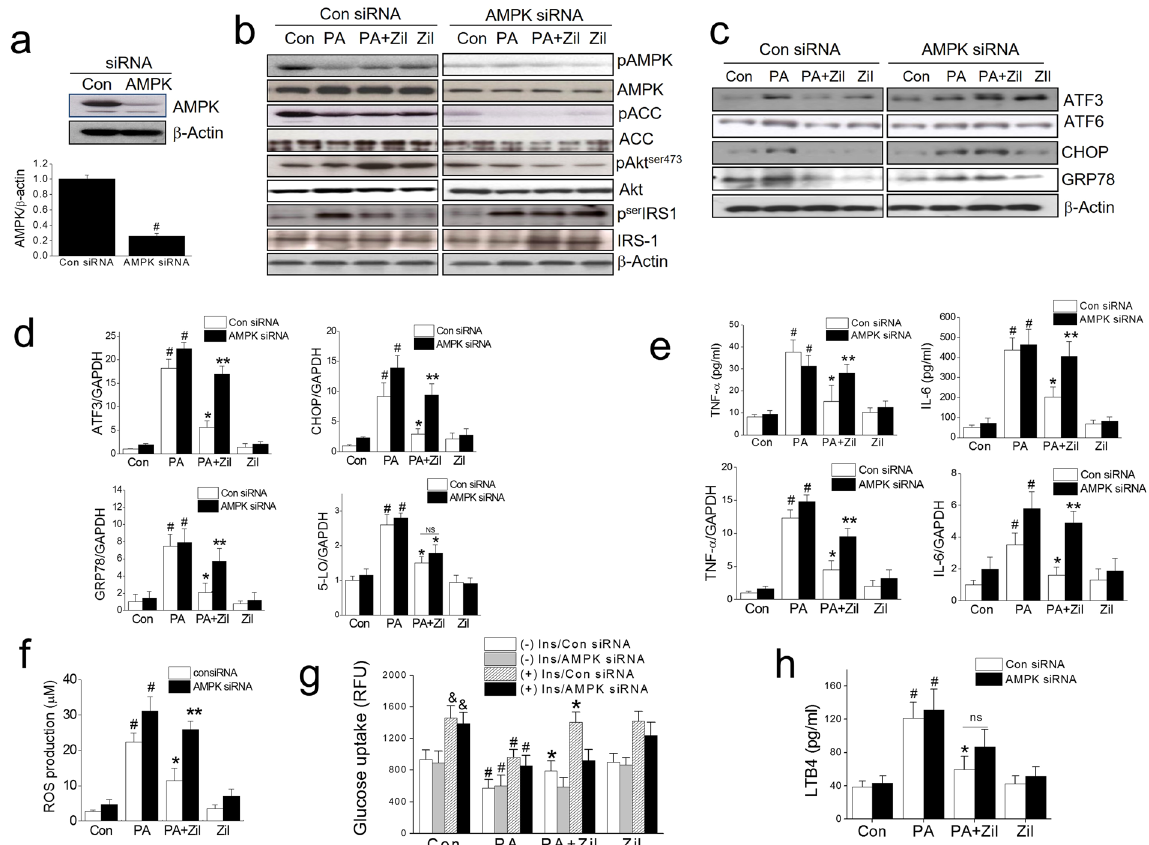
Figure 7. The effect of AMPK knockdown on the zileuton action. C2C12 myotubes were transfected with negative control siRNA or AMPK siRNA (20 nM), treated with 50 μ M zileuton for 1 h, and then with PA (750 μ M) for 12 h (qPCR) or 24 h (western blot, ELISA, ROS, and glucose uptake). The effect of AMPK knockdown was determined by western blotting ( a ). The effects of AMPK siRNA on Akt/serIRS-1 phosphorylation, and AMPK/ACC phosphorylation ( b ) and ER stress markers were determined by western blotting ( c ) and qPCR ( d ). The expression of 5-LO was determined by qPCR ( d ). Cellular TNF- α and IL-6 mRNA levels and secreted TNF- α and IL-6 levels were determined by qPCR and ELISA ( e ). ROS production was assessed using AmplexRed ( f ). Glucose uptake was determined by 2-NBDG in the presence or absence of insulin (1 μ g/ml) for 30 min ( g ). LTB4 production was measured by ELISA kits ( h ). The results of the western blotting are shown as the representative of three independent experiments ( b and c ), and other results are expressed as the means ± SDs of three experiments performed in triplicate. # P < 0.05 vs . non-treated controls, * P < 0.05 vs . PA alone, ** P < 0.05 vs . control siRNA of PA plus zileuton, & P < 0.05 vs . ( − ) insulin, ns; not